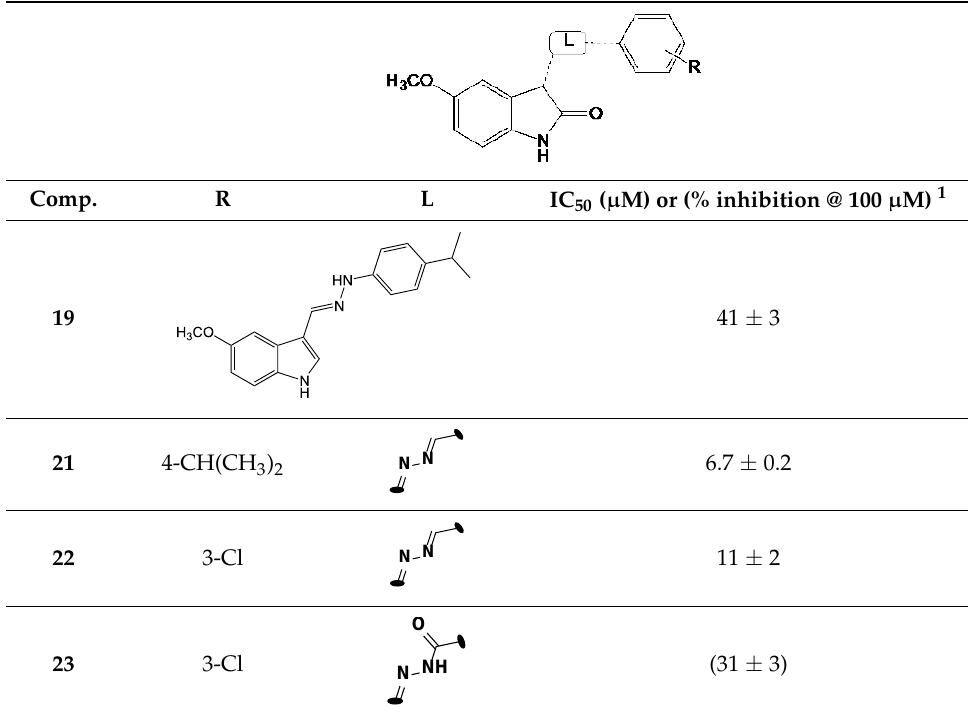
Table 3. A β Antiaggregating Activity of Compounds 19 and 21 – 23.